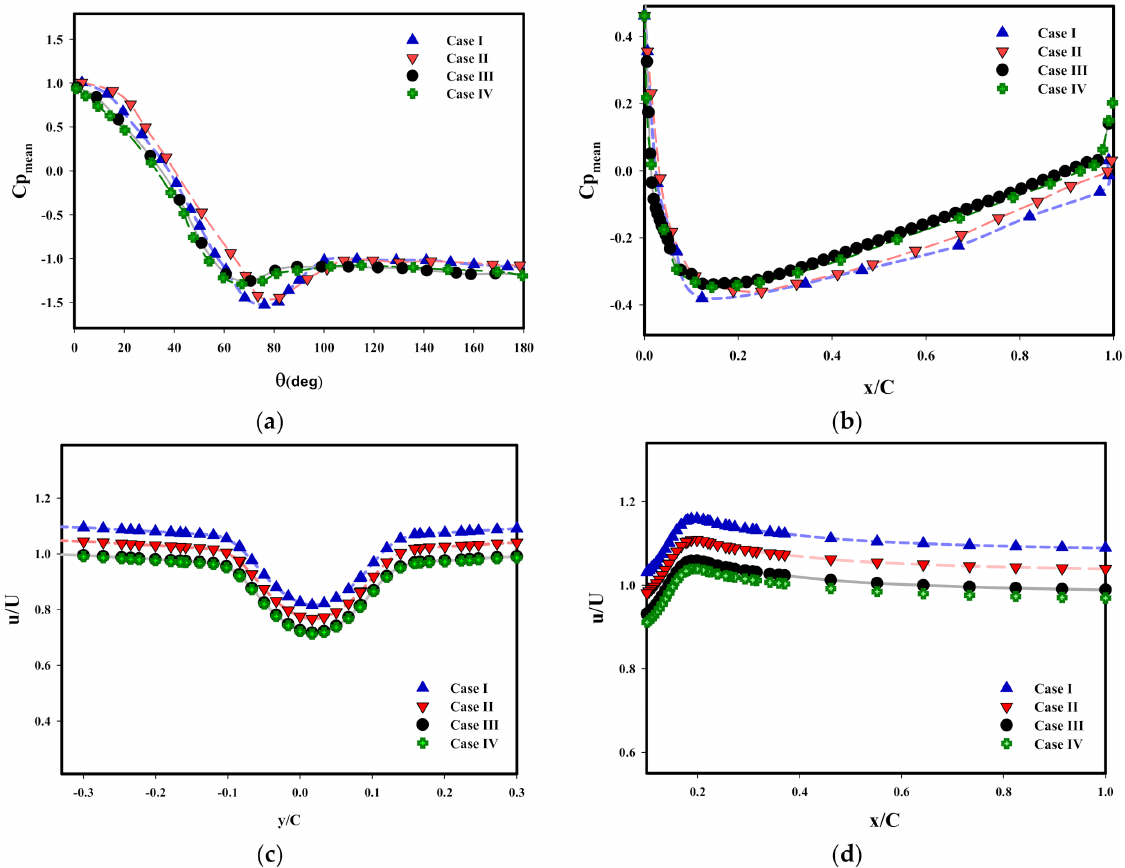
Figure 5. Reviewing independency of the results from the grid: ( a ) the mean pressure coefficient around the rod, ( b ) the mean pressure coefficient around the airfoil (lower surface), ( c ) mean velocity at x/C = − 0.25, ( d ) mean velocity at x/C = +